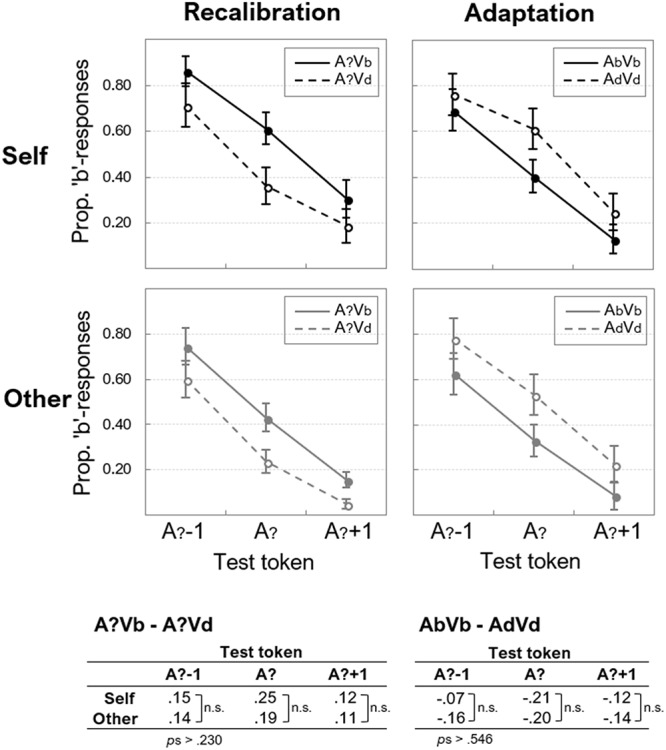
Auditory aftereffects after AV exposure. The proportion of “b”-responses (y-axes) are given for each test-token (x-axes) in the auditory test that followed exposure to ambiguous (left panels) and unambiguous (right panels) AV exposure stimuli, for “self” and “other.” Error bars represent standard errors of the means. The differences per token are provided below the panels, where recalibration is reflected by positive values, and adaptation by negative ones.